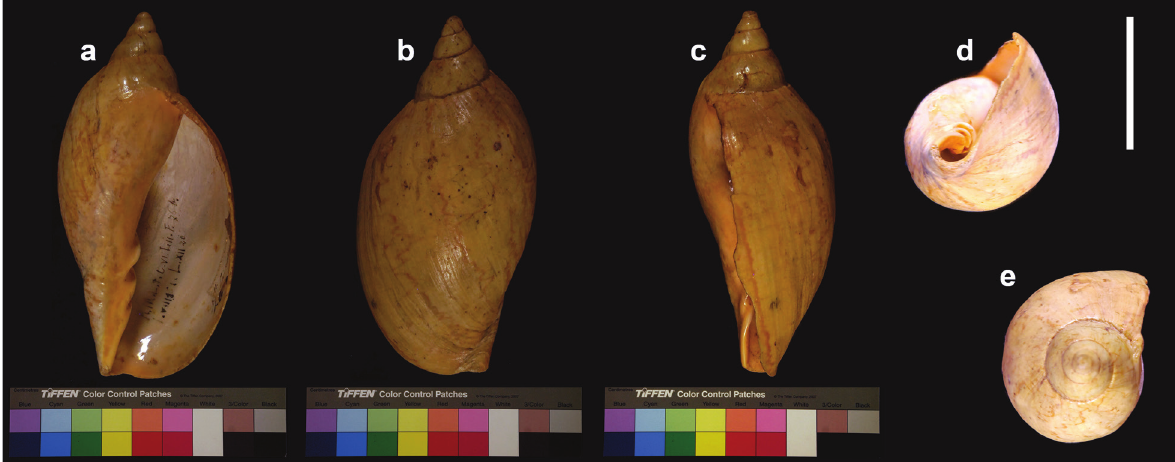
Figure 48. Voluta paradoxa typica specimen figured by Lahille (1895: pl. II, fig. 76b; pl. VIII, fig. 161; pl. XII, fig. 20) a Apertural view b Dorsal view c Lateral view d Umbilical view e Apical view. Scale bar: 5 cm.